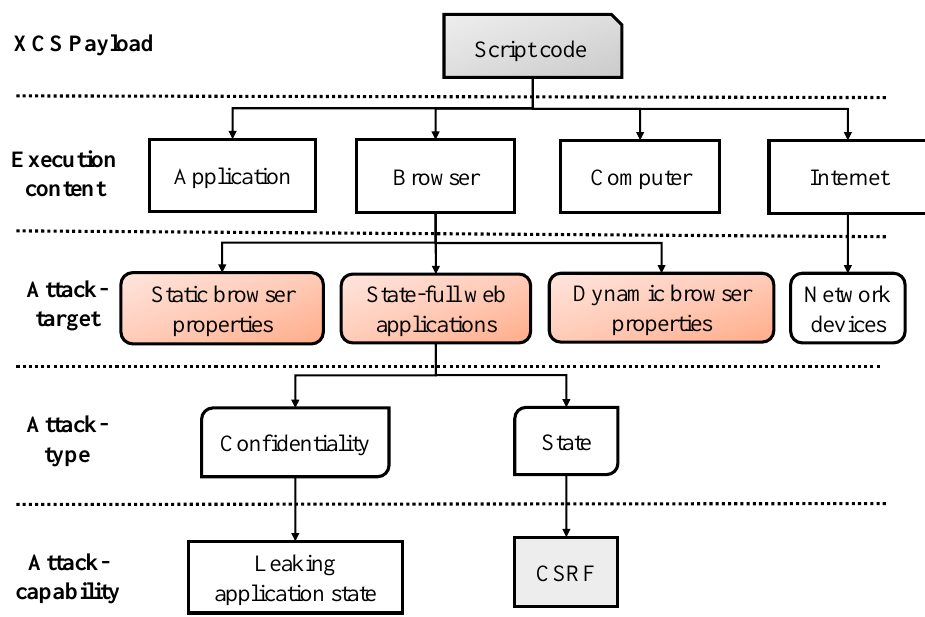
Figure 1. XCS payload execution and attack